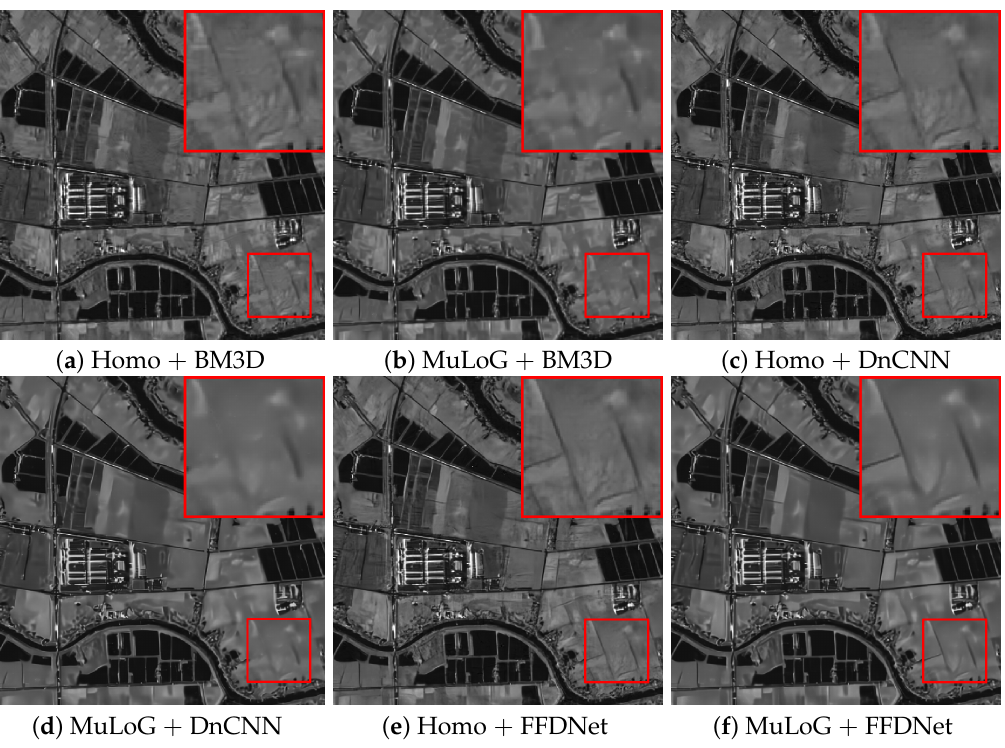
Figure 11. The denoising results for real SAR image: Data 2: ( a – f ) Homo + BM3D, MuLoG + BM3D, Homo + DnCNN, MuLoG + DnCNN, Homo + FFDNet, and MuLoG + FFDNet, respectively. Table 3. The quantitative comparison of different methods for real SAR image: Data 1.